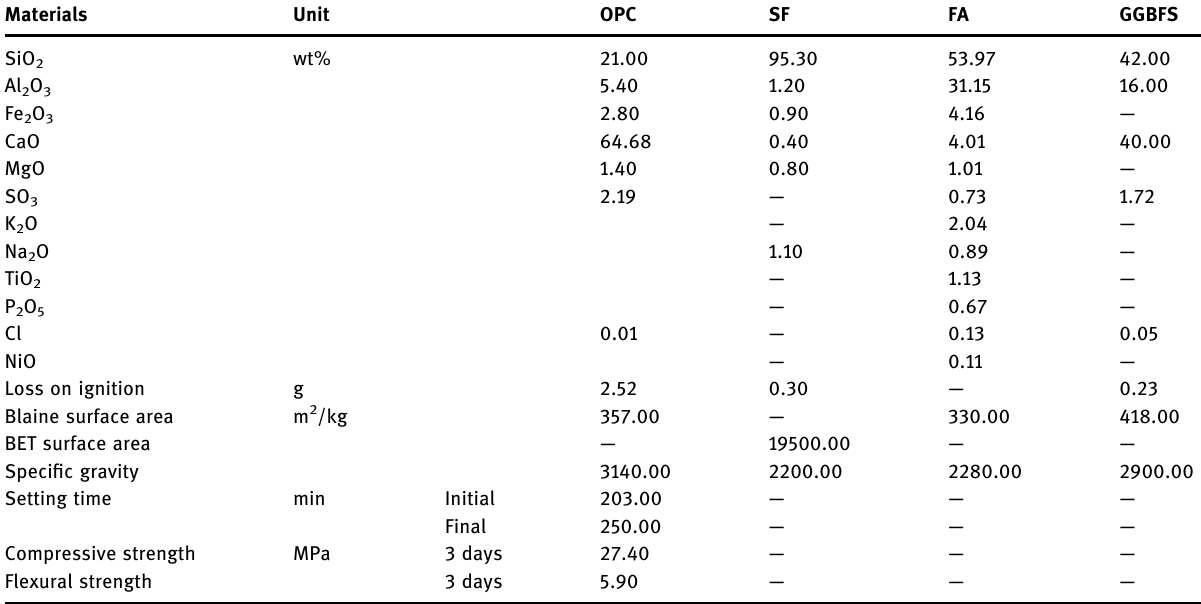
Table 1: Compositions and properties of binder materials Materials